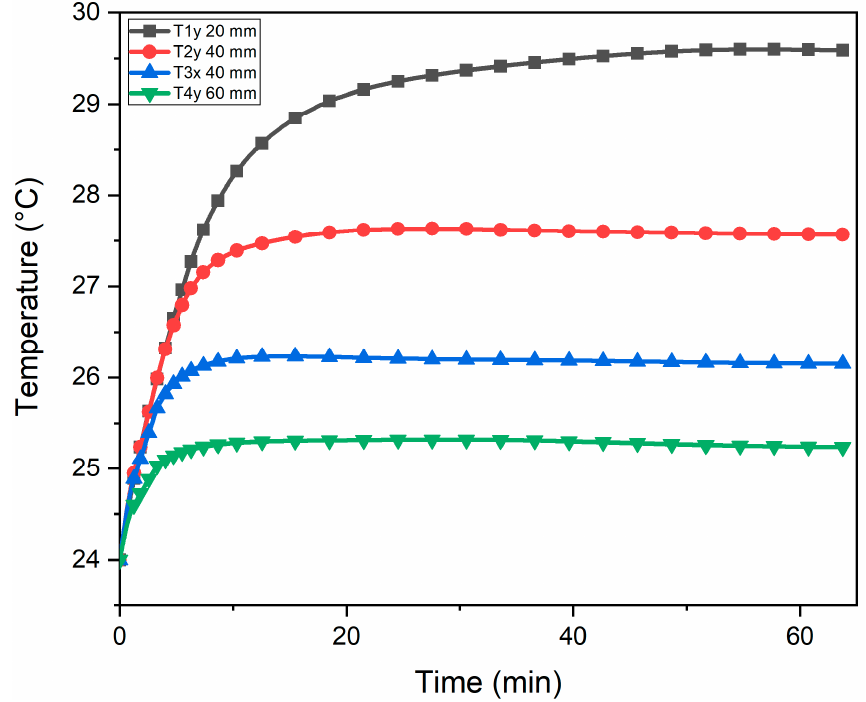
Figure 8. Temperature profile along the x- and y-axis for crossflow configuration with 20 W power input.